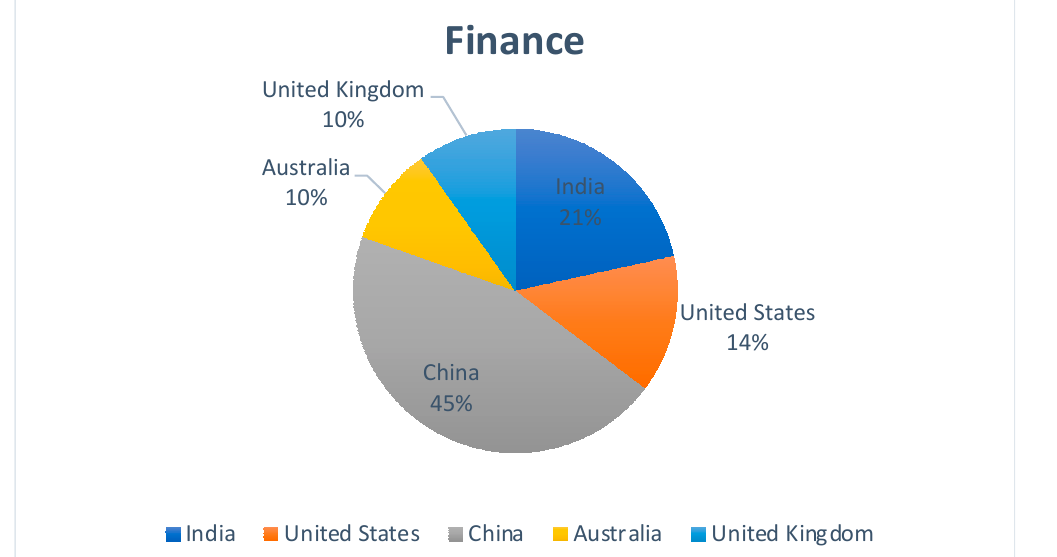
Figure 6. Region-specific publication distribution for Blockchain–Cloud and Finance.